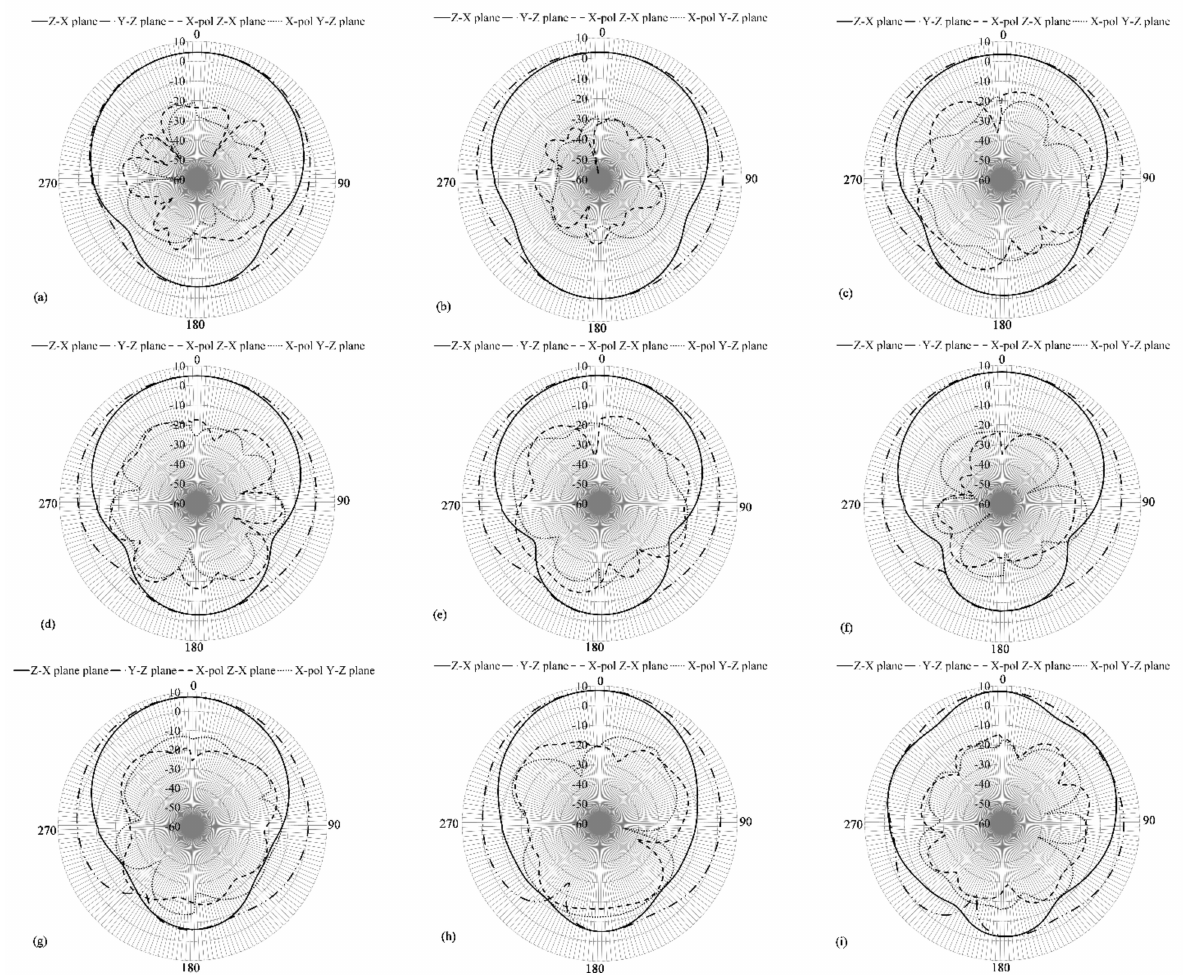
Figure 14. Simulated gain pattern of the proposed array, ( a ) 1.88 GHz, ( b ) 2 GHz, ( c ) 2.2 GHz, ( d ) 2.5 GHz, ( e ) 2.8 GHz, ( f ) 3.2 GHz, ( g ) 3.8 GHz, ( h ) 4.5 GHz, and ( i ) 5.5